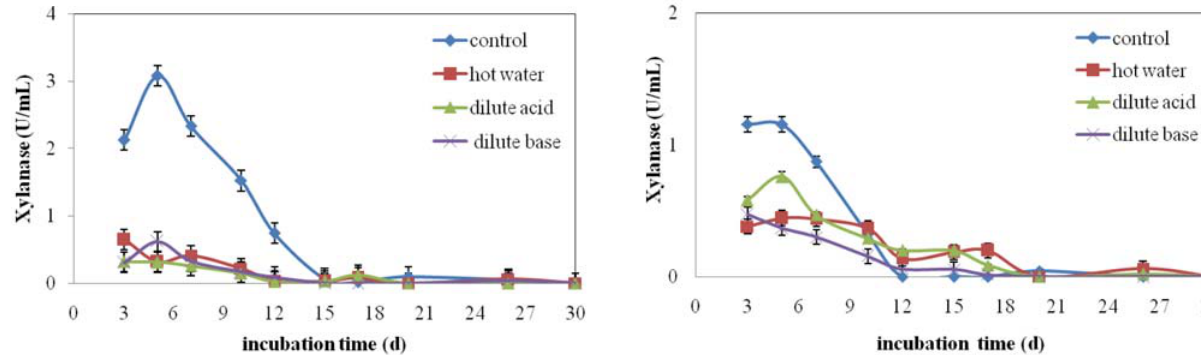
Figure 2. Variations of xylanase activities depending on peach (left side) and cherry (right side) cultures. The values are the mean ± SD for experi- ments of three separate experiments.